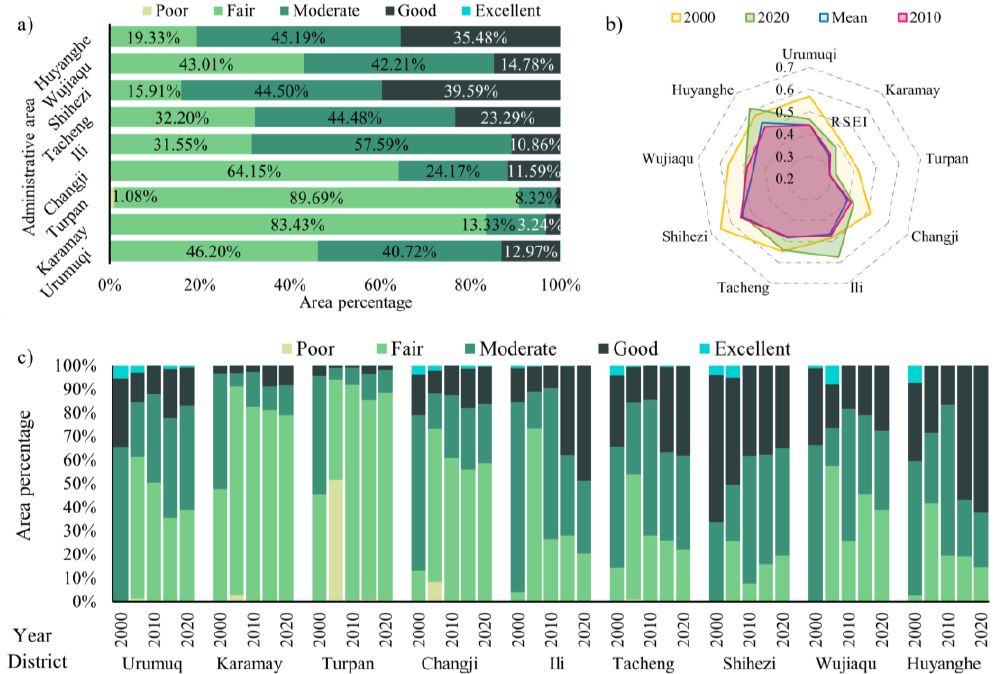
Figure 7. Ecological quality of localized areas. ( a ) Distribution of multi-year RSEI means in different administrative units. ( b ) Annual RSEI for different administrative units. ( c ) Corresponding proportion of RSEI grades and administrative regions of the UANSTM.